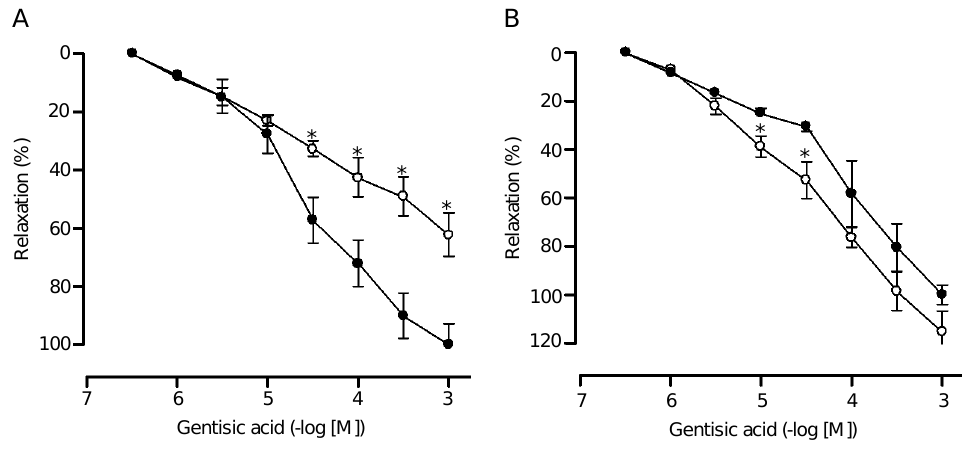
Figure 5 - Mean relaxant concen- tration-response curves for gen- tisic acid in the guinea pig tra- chea without epithelium in the absence (filled circles) or pres- ence of: A , porcine D- P -Cl- Phe 6 ,Leu 17 [VIP] (open circles, 0.1 µM); B , CGRP (8-37) (open circles, 0.1 µM). Data are re- ported as means ± SEM of 6 experiments. *P<0.05 for the difference between points (Stu- dent t